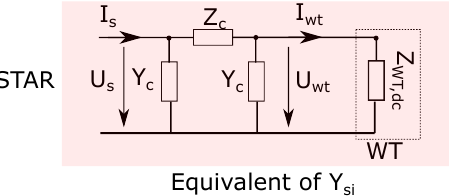
Figure 19. Equivalent model of a WT connected to the Star point through a submarine cable